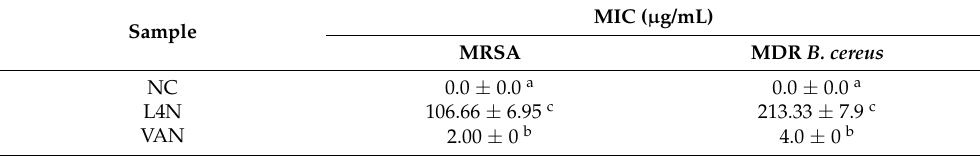
Table 4. MIC of luteolin 4 (cid:48) -neohesperidoside (L4N) against MRSA and B. cereus.